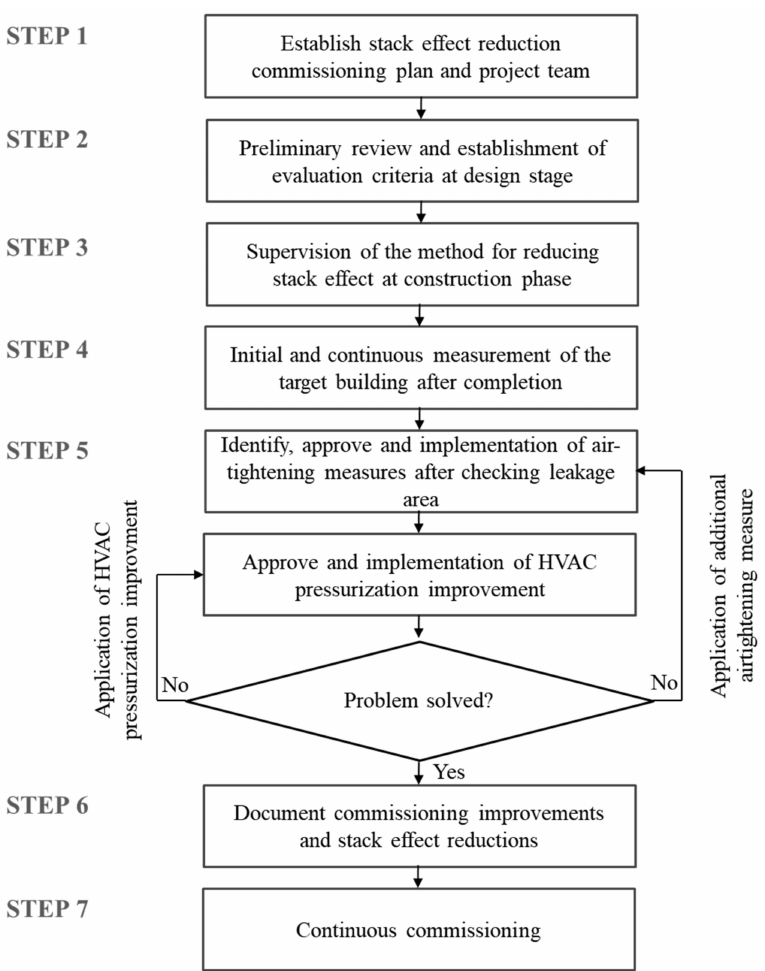
Figure 13. Flowchart of the building commissioning process to resolve the stack